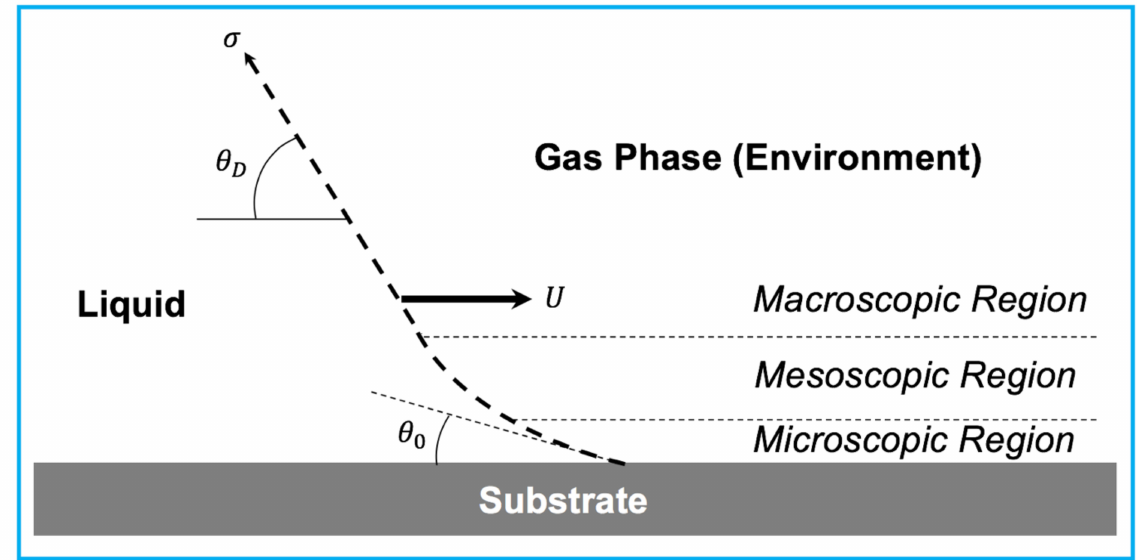
Figure 7. Schematics of hydrodynamics theory to explain the physics of dynamic contact line due to viscous bending near the contact